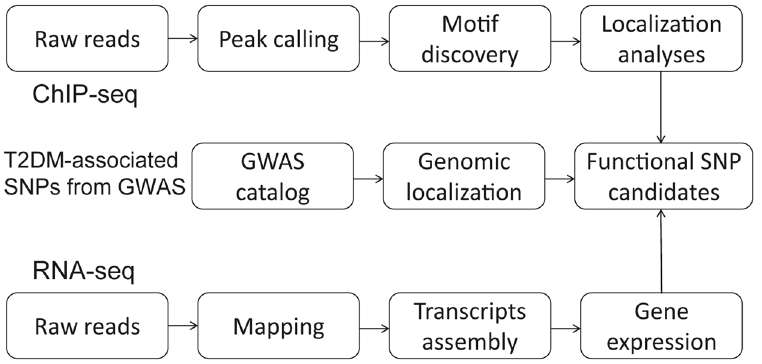
Figure 1. Overview of the integrated transcriptome and epigenome analysis (iTEA) for functional DNA variant identification. The pipeline of iTEA consisted of SNP collection, chromatin state characterization (ChIP-seq) and gene expression quantification (RNA-seq). To characterize the chromatin state, peak calling and motif finding were used. Then, genetic and epigenetic mapping of diabetic risk loci was implemented to prioritize and search for SNP candidates. Firstly, obtaining the T2DM SNP candidates from NHGRI GWAS catalog. Secondly, calling peaks and discovered motifs in ChIP-seq data, and aligning the motifs with SNPs to confirm whether the SNP was located in the regulatory region. Third, mapping the SNPs and assembling transcripts using FPKM for RNA-seq data to further confirm the location of functional SNP candidates, as the functional SNP can regulate the gene expression.